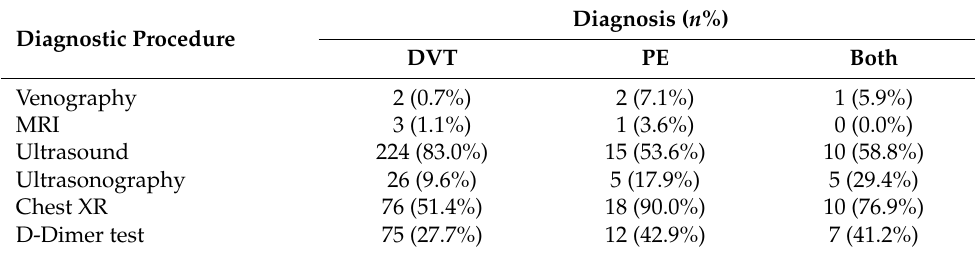
Table 1. The diagnostic procedures performed for patients with DVT, PE or